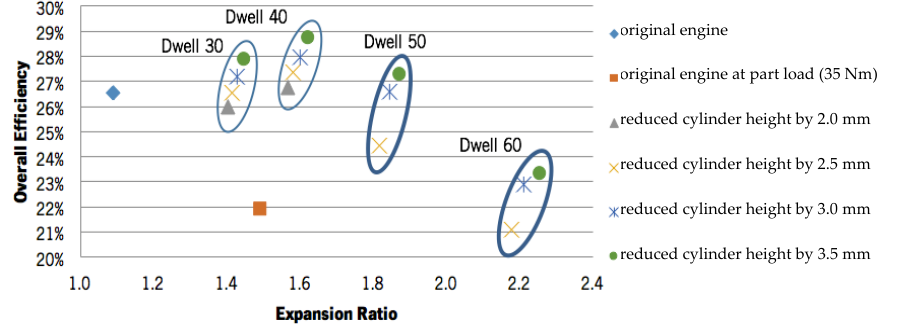
Figure 3. Estimated engine overall efficiency for different cam dwells, compression ratio (reduction) as a function of the expansion ratio.